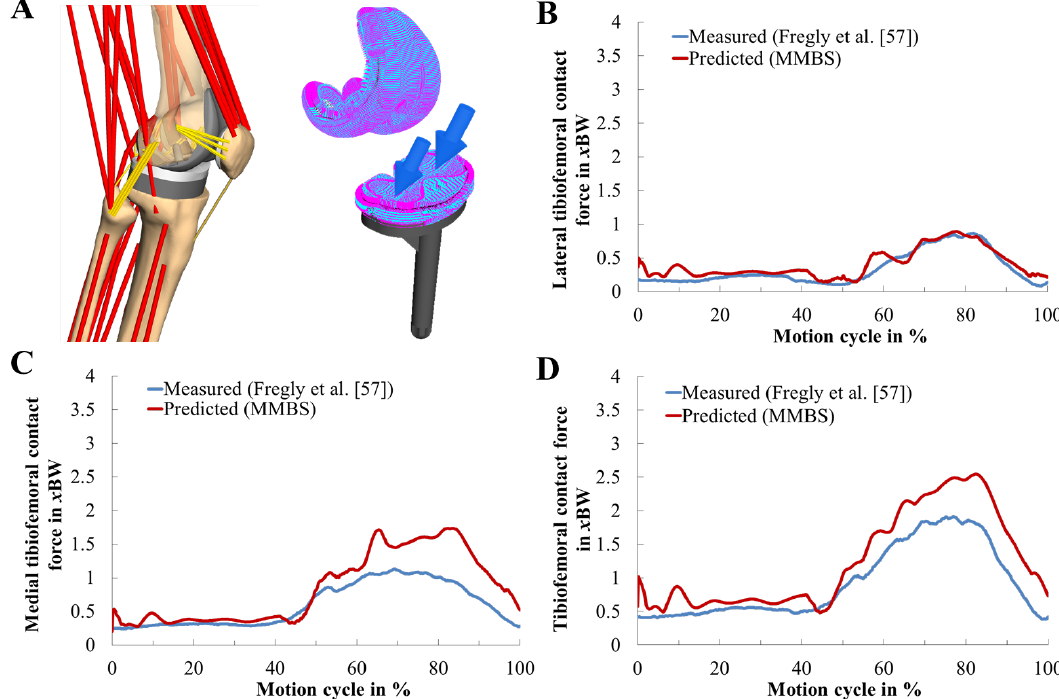
Figure 4. Musculoskeletal multibody simulation of the patellofemoral joint during the dynamic squat motion ( A ). Model validity was confirmed by comparing the reported lateral ( B ), medial ( C ), and total ( D ) tibiofemoral contact forces (in unit of body weight BW) of the in vivo measurements (blue, [57]) to our predictions